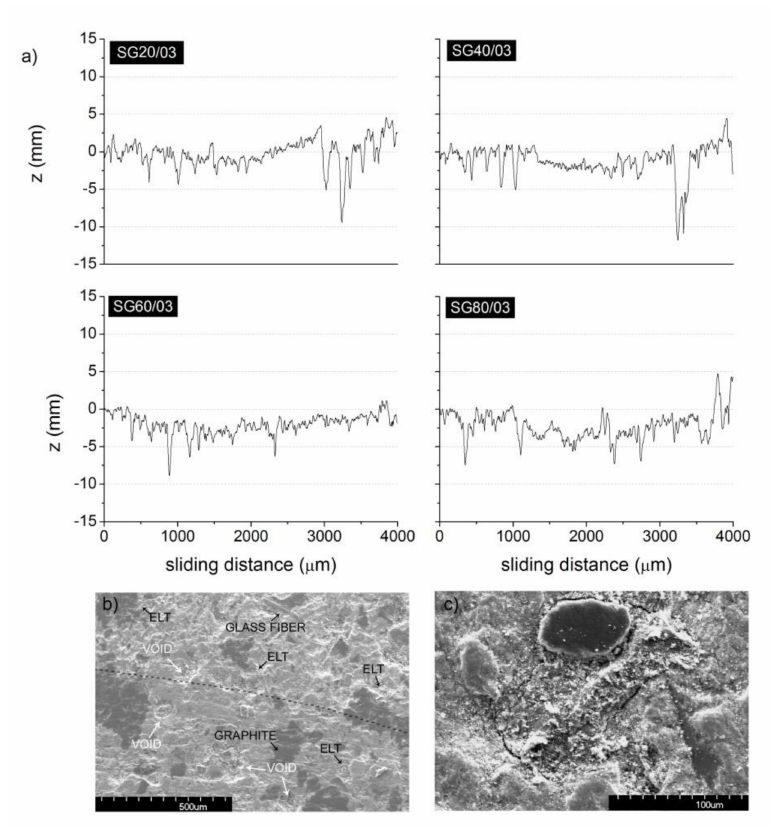
Figure 5. ( a ) Surface profiles after the friction test of the composite pad elements containing rubber particles C20, C40, A60, and A80. ( b ) SEM image of a tested brake pad C20/03 (dotted line indicates the limit of the pin-on-disk test) and ( c ) SEM image of a ELT rubber particle in C20/03 brake pad.